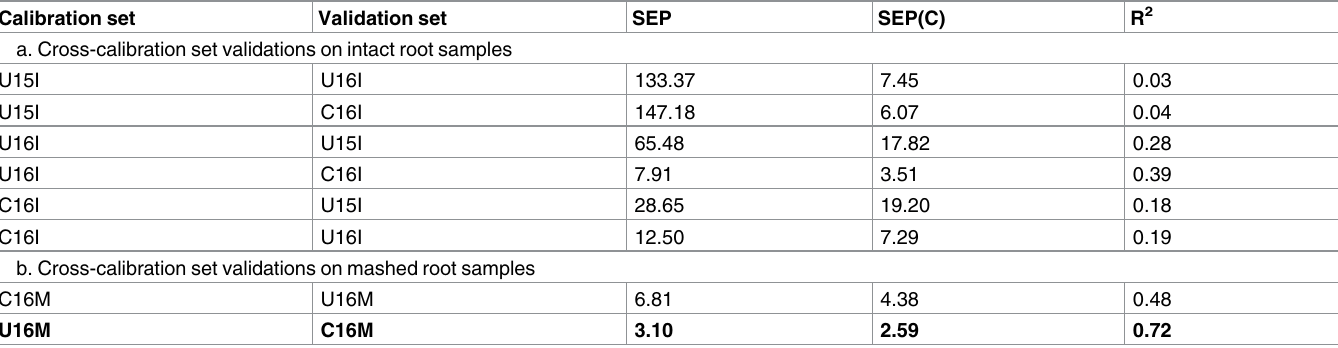
Table 7. Validation using different calibration sets on intact and mashed root samples for DMC.